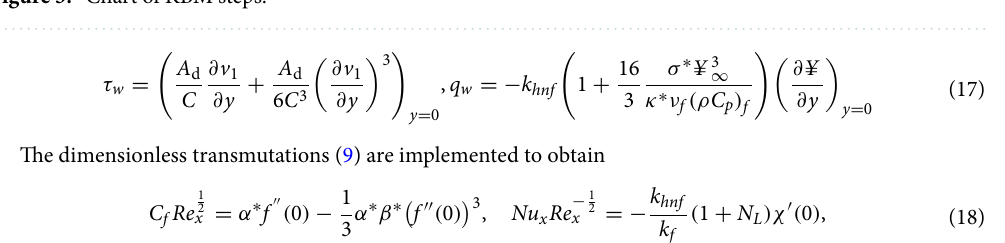
Figure 3. Chart of KBM